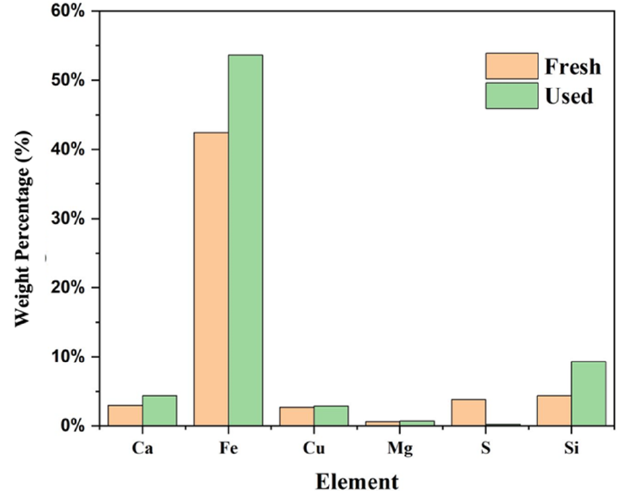
Figure 14. Element contents of the fresh and used CA70-bonded oxygen carriers.